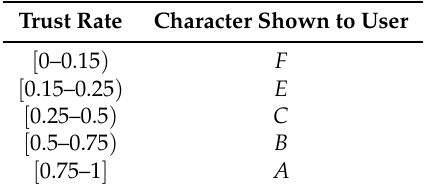
Table 3. Equivalence between Trust Rate and Character Shown to User.